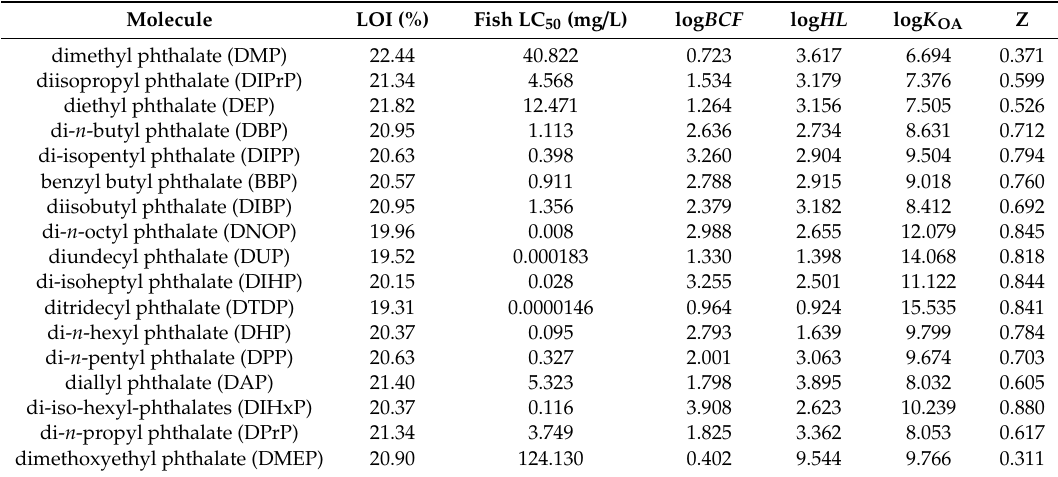
Table 1. Limited oxygen index (LOI), LC 50 , log BCF , log HL , log K OA parameters of 17 phthalic acid esters (PAEs) and their comprehensive evaluation value Z for flammability, biotoxicity, and